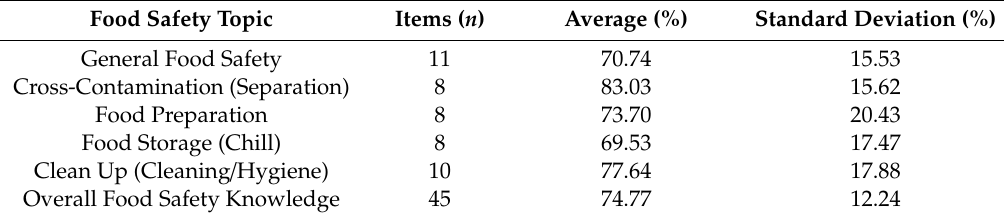
Table 3. Food Safety Knowledge Scores by Section.